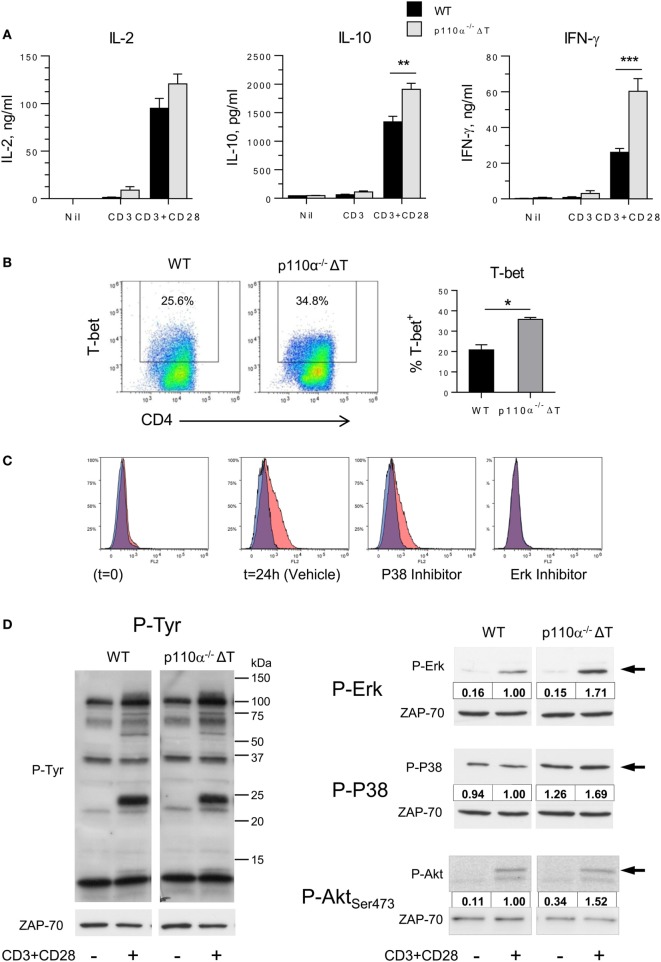
Effect of PI3-kinase p110α removal on naive T cell activation. (A) Naive CD4+ T lymphocytes from WT or p110α-T cell deficient (p110α−/−ΔT) mice were activated with plate-bound anti-CD3 plus anti-CD28, as indicated. At 72 h, IL-2, IL-10, and IFN-γ content in the supernatants was determined. Mean from three experiments ± SE. Asterisks indicate significant differences (**p < 0.01; ***p < 0.001) between groups, as determined by the Student’s t-test. (B) Naive CD4+ T lymphocytes from WT or p110α−/−ΔT mice (WT) were activated with plate-bound anti-CD3 plus anti-CD28 for 24 h, then analyzed for T-bet expression by flow cytometry. Mean from three determinations ± SE. Significant differences between data are indicated (*p < 0.05). (C) Effect of MAPK inhibitors on T-bet induction. Naive CD4+ T lymphocytes from WT mice were activated as in (B) in the presence of vehicle (DMSO), or the P38 inhibitor SB203580 (2 µM), or Erk inhibitor U0126 (5 µM), as indicated in the histograms. Red histograms: anti-T-bet; Blue histograms: control antibody. (D) WT or p110α−/−ΔT naive CD4+ T cells were activated for 20 min with CD3 plus CD28 stimulus. Cell lysates were then analyzed by immunoblot. Cells lacking PI3K p110α show increased phosphorylation of distinct proteins (left panel) as well as of activated forms of the ERK and P38 MAP kinases (center and right panels, and histograms), or Akt Ser473 phosphorylation (right panels). Relative OD of CD3/CD28-activated WT cells was considered = 1.00. Data from one experiment of three independent experiments performed.